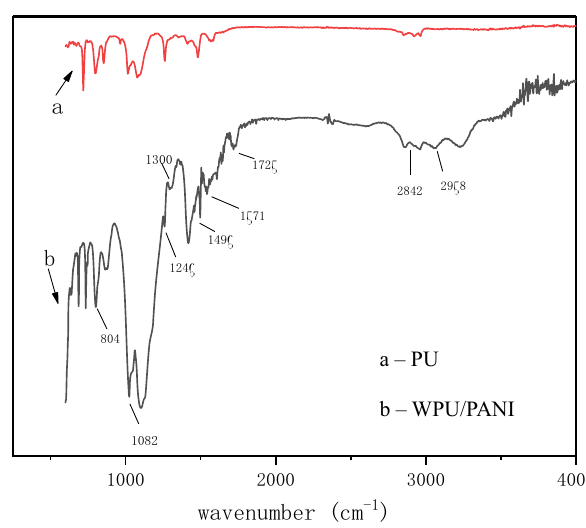
Figure 2: Infrared spectra of WPU/PANI composite fi lm matrix fi lm.